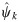
Quantifying temporal disruptions of grid patterns.a) Generated spike locations with 2000 spikes (left). Each spike k is color-coded with its grid score ψ^k. The first 1000 spikes are drawn from a spatially uniform distribution (top right) and the last 1000 spikes are drawn from a perfect grid (bottom right), at a constant rate of 1 spike per second. b)
ψ^k scores in a as a function of spike time. Note that the score of many spikes is 0. c) The scores from b, filtered with a 100 second time window (dotted lines indicate window size). d) Two experimentally recorded spike maps, color coded with ψ^k scores. The recordings are 52 minutes in total and contain 13 trials in light (with an illuminated cue card) and 13 trials in darkness, each of 2 minutes duration. e) The ψ^k scores as a function of time, filtered with a 1 minute window. From top to bottom: First cell from d; second cell from d; mean over both cells. Shadings indicate light trials. Pearson’s correlation coefficients, r, between lighting condition and filtered grid scores are shown for each scenario. f) Spike maps for cell 1 and cell 2, separated into spikes fired during light trials and spikes fired during dark trials. g) Temporal evolution of grid scores after changes in lighting condition. Each 2 minute trial was separated into 12 × 10 second blocks. Each point shows the mean ψ^k score of all spikes in a time block in light trials (light blue) and dark trials (dark blue), averaged over 73 grid cells. Grid scores are calculated in reference to all spikes during light trials (see text for details). Experimental data recorded and made publicly available by Pérez-Escobar et al. [21].